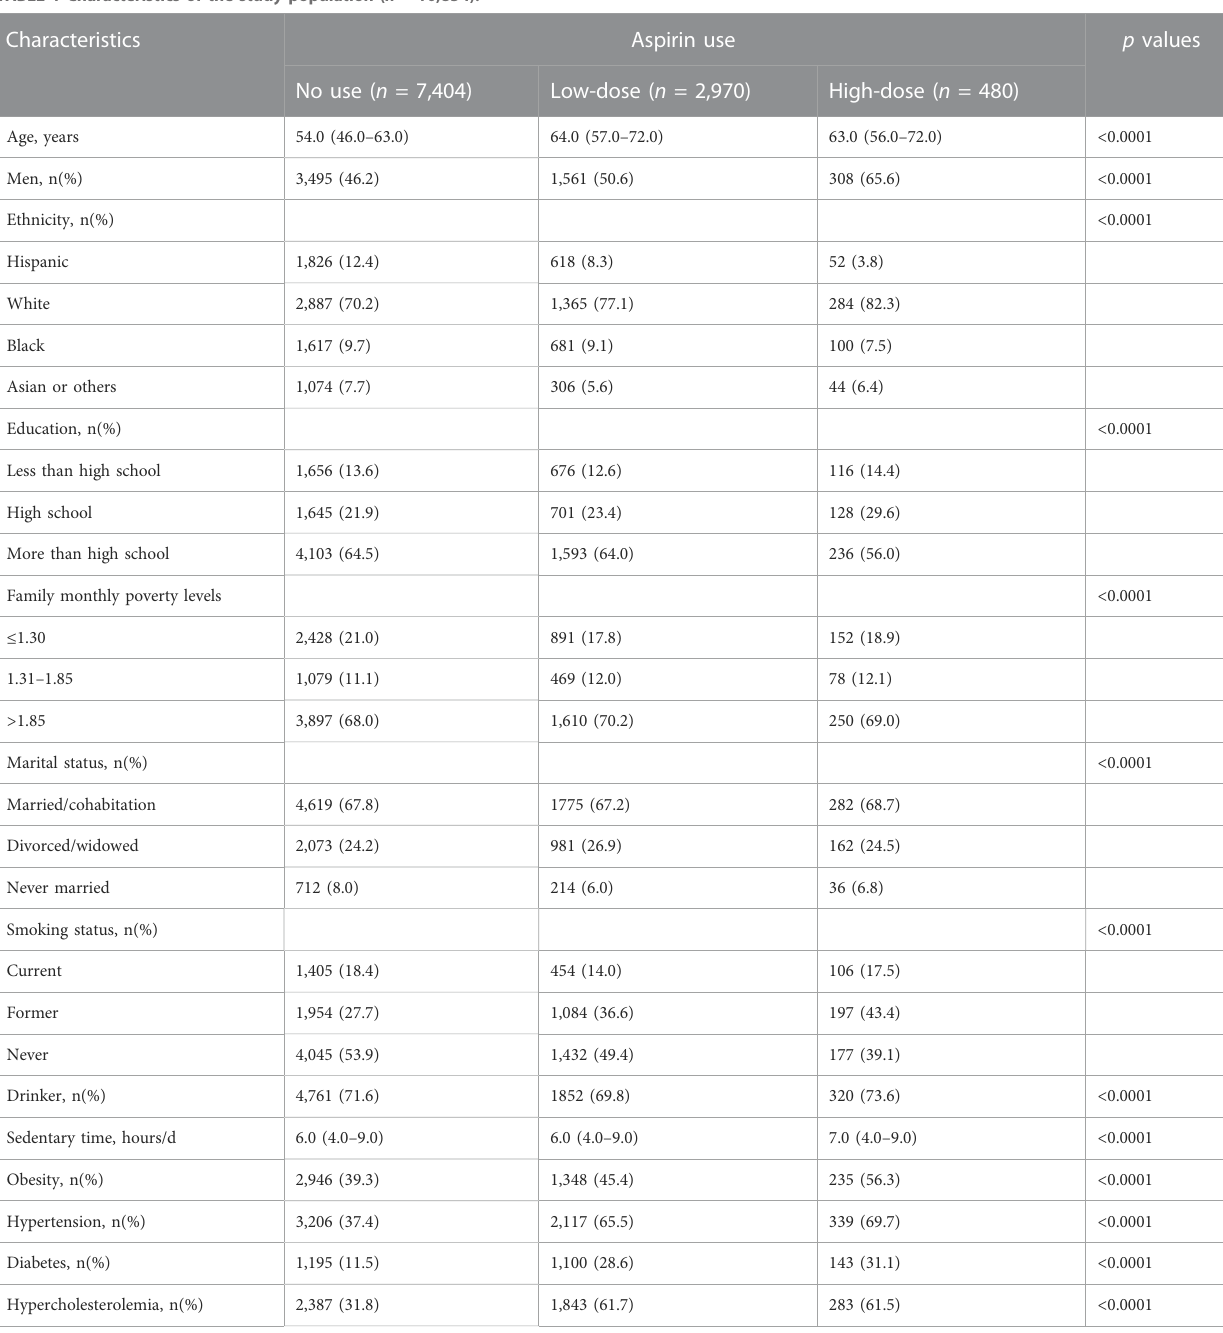
TABLE 1 Characteristics of the study population ( n = 10,854).